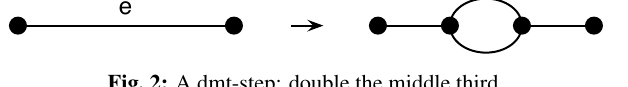
Fig. 2: A dmt-step: double the middle